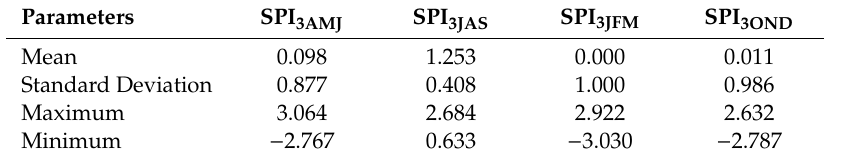
Table 5. Summary of SPI3 magnitudes for the historical rainfall records from 1980 to 2017.